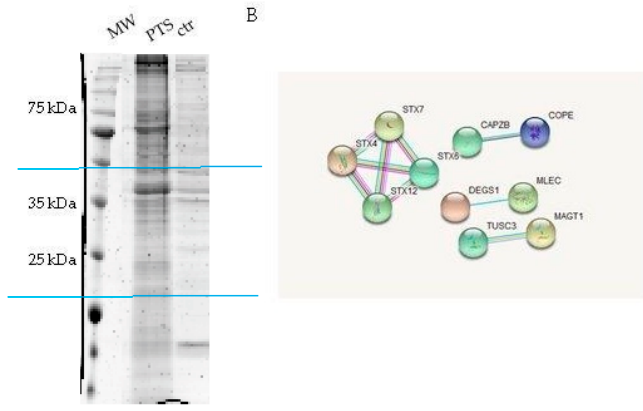
Figure 2. Panel A : SDS-PAGE of the eluted proteins from PTS-bearing and control-beads (two independent experiments); gel regions submitted to trypsin digestion included in blue lines. Panel B : String networks between PTS partners (https: // string-db.org /